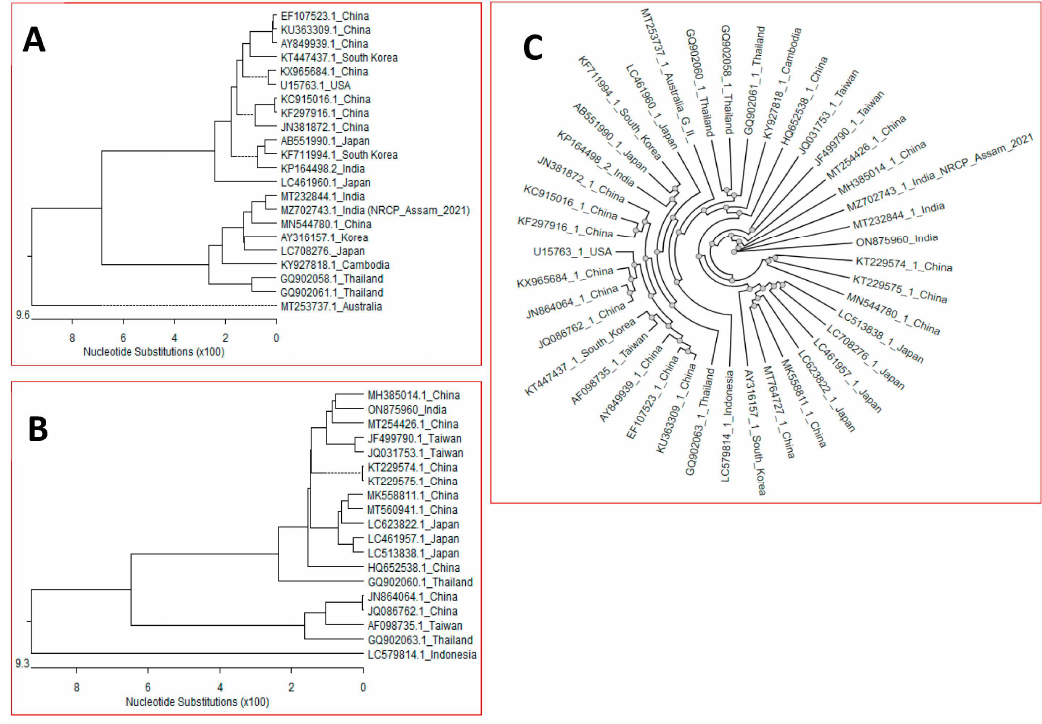
Figure 5. Representation of phylogenetic profile of the JEV isolates, ( A ) isolates from pigs, and ( B ) isolates from the vector Culex tritaeniorhynchus mosquito based on a comparison of the whole polyprotein gene, ( C ) Phylogenetic tree of JEV isolates from pig & mosquito, point of origin.